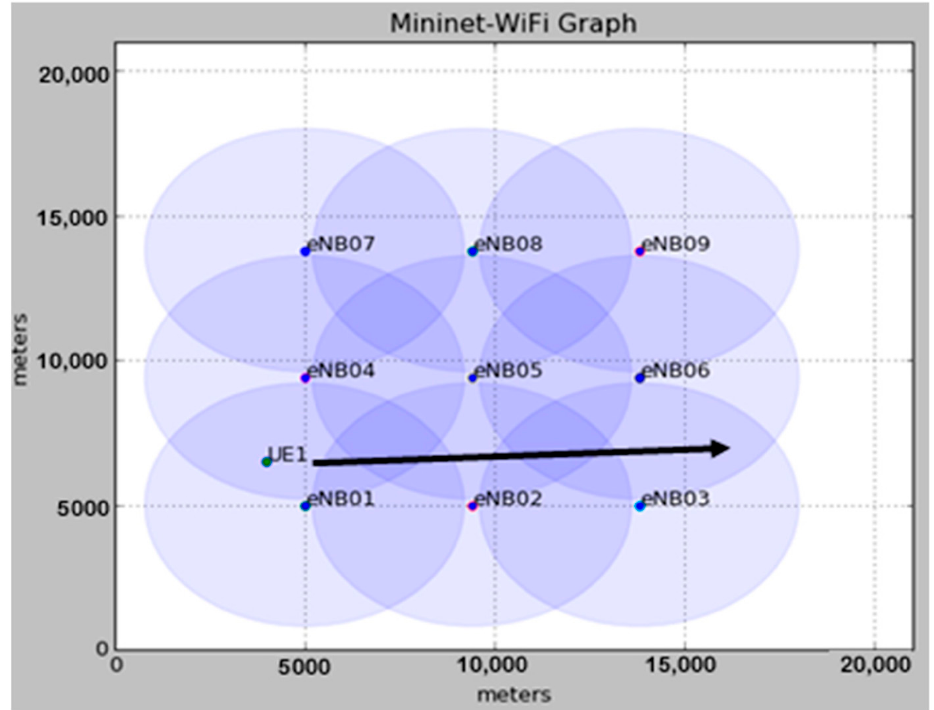
Figure 20. UE’s moving path for handover mechanism testing.